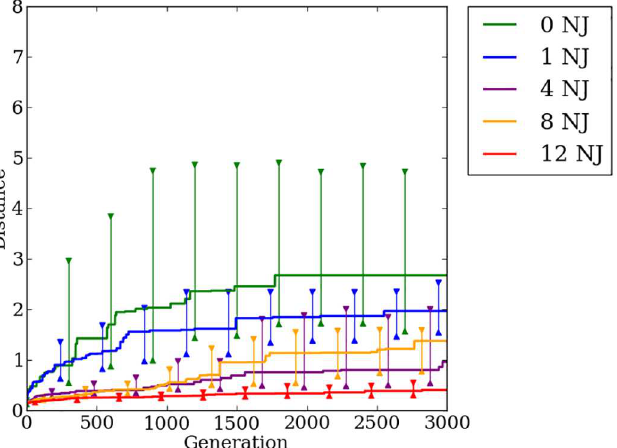
Fig 22. The median distance traveled by Auto-Switch-HybrID generation champions over 3,000 generations on the quadruped robot transfer experiment. The line colors indicate the numberof noisy joints on the robot. 95% bootstrapped confidenceintervalsof the medianare shown every 300 generations.